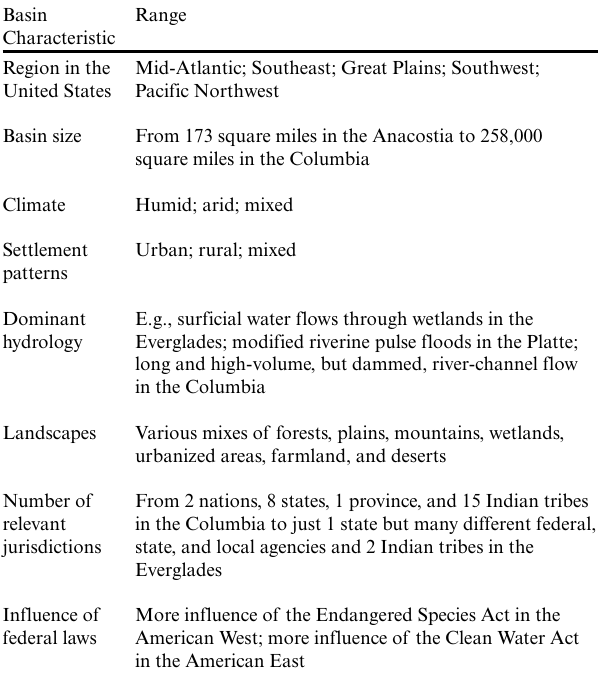
Table 1 . Range of basin